Question: In one sentence, what is this figure communicating?
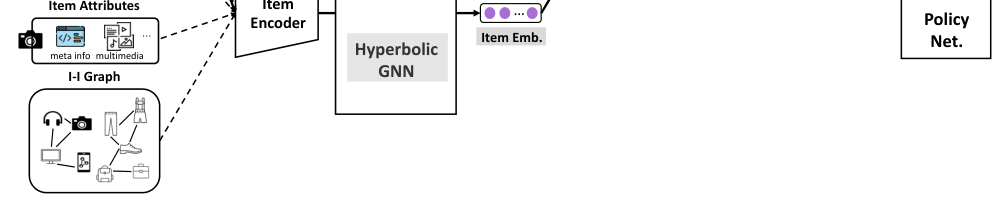
Answer: Overview of architectures for GNN-based SocialRS methods. The solid lines represent the common procedure of the GNN-based SocialRS methods, while the dashed lines represent the flows for the auxiliary inputs or the losses.